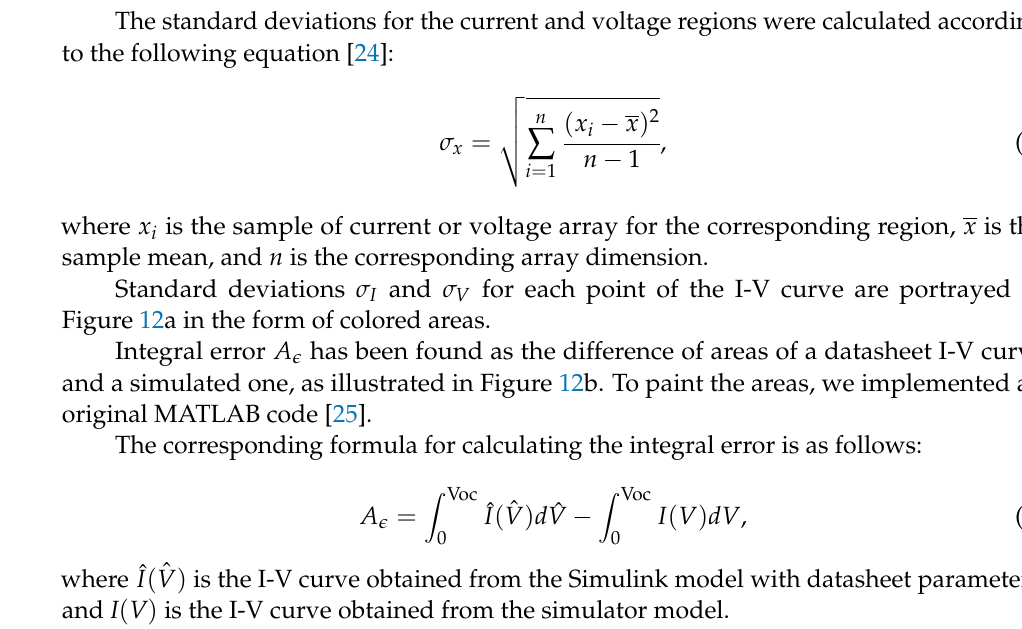
Figure 11. Families of I-V curves provided by the solar panel simulator for temperatures ( a ) T = 25 ◦ C; ( b ) T = 0 ◦ C; ( c ) T = − 25 ◦ C; ( d ) T = − 40 ◦